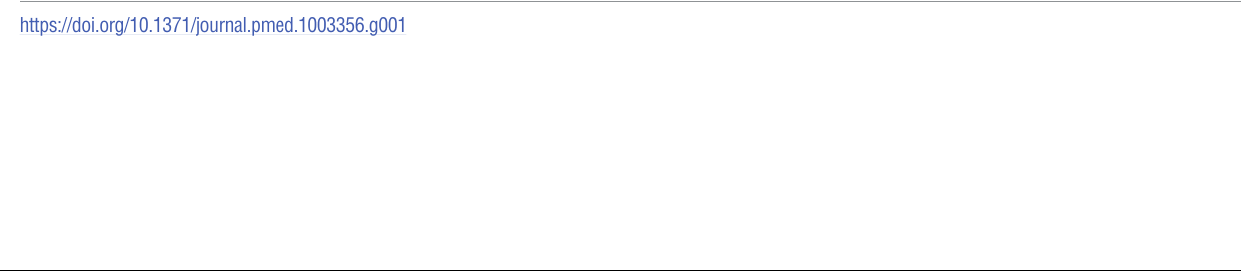
PLOS Medicine| https://doi.org/10.1371/journal.pmed.1003356 September 28, 2020 8 /